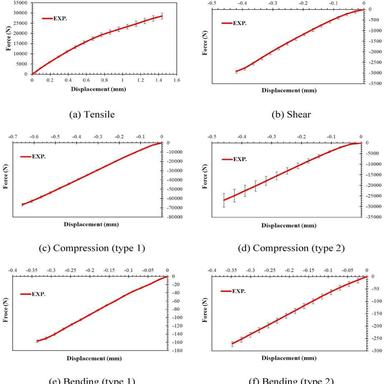
Test results from six experimental groups represented by the force and displacement.